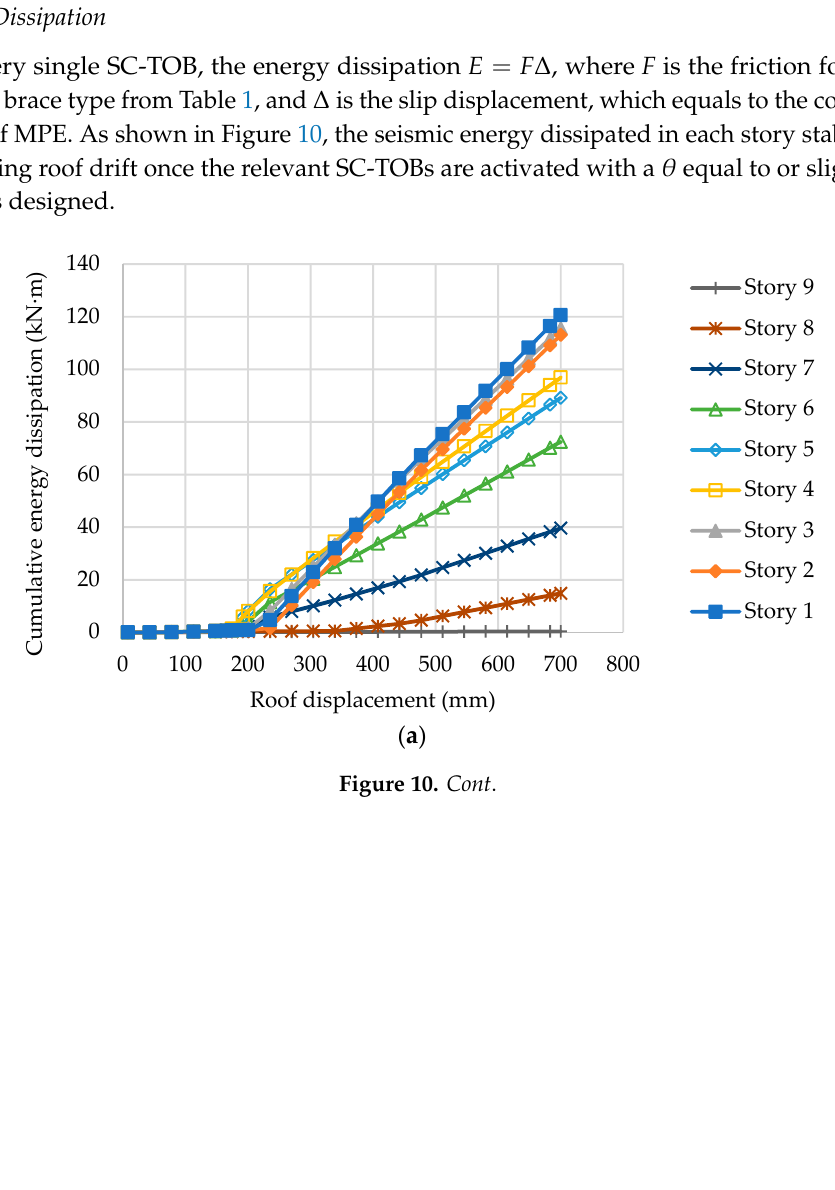
Figure 9. Inter-story drift response under ( a ) LD-P and ( b ) LD-U.